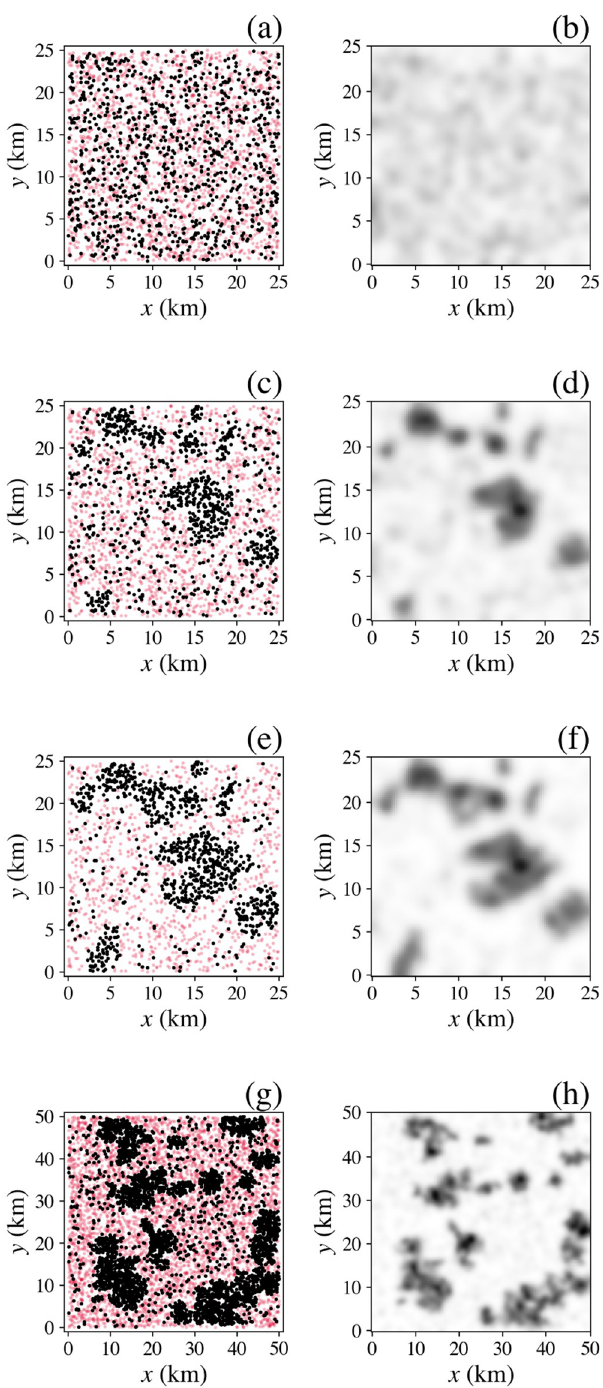
Fig 7. City formation and clustering effects. Spatial distribution (left) of households (black) and dwellings (red) and smoothed distribution (right, same grayscale in all frames) of households at various times: ( a ) and ( b ) t = 0 years, ( c ) and ( d ) 10 years, ( e ) and ( f ) 25 years. ( g ) and ( h ) Results for a larger system with R = 50 km and the same initial density of dwellings and households. Note that colors appear denser in (g) because four times as many points are plotted.